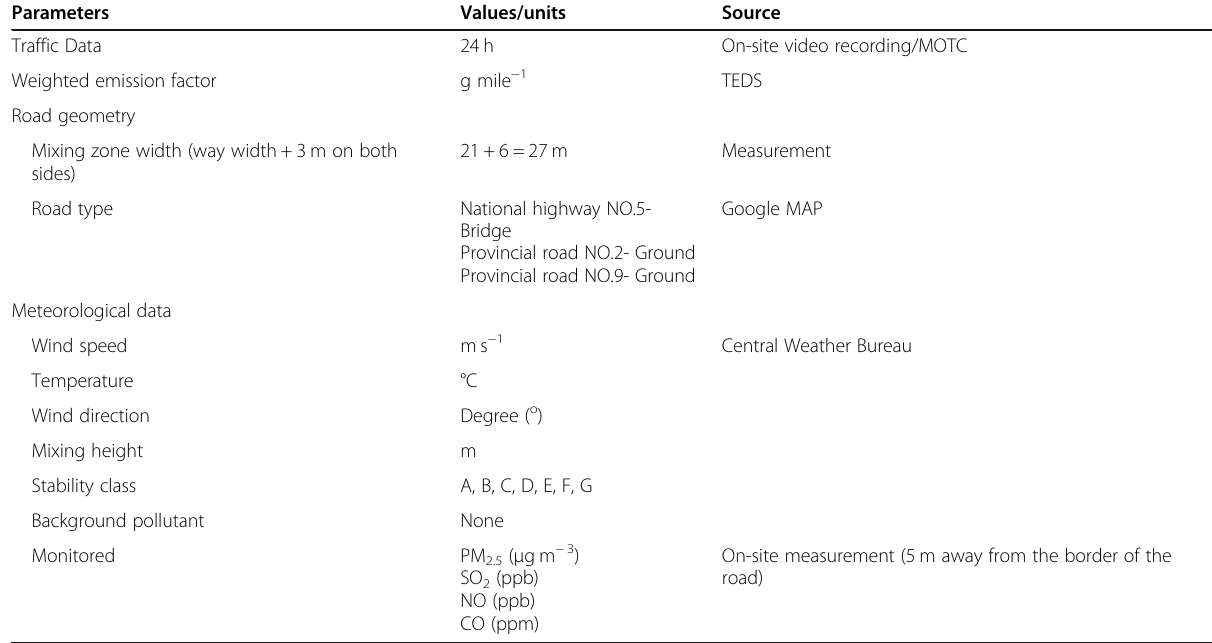
Table 1 Input parameters in CALINE4